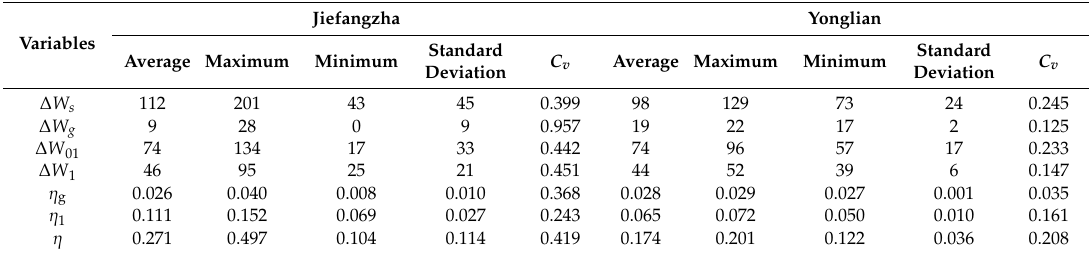
Table 4. Statistical results of ∆ W s , ∆ W g , ∆ W 01 , ∆ W 1 , η g , η 1 and η in Jiefangzha and Yonglian.